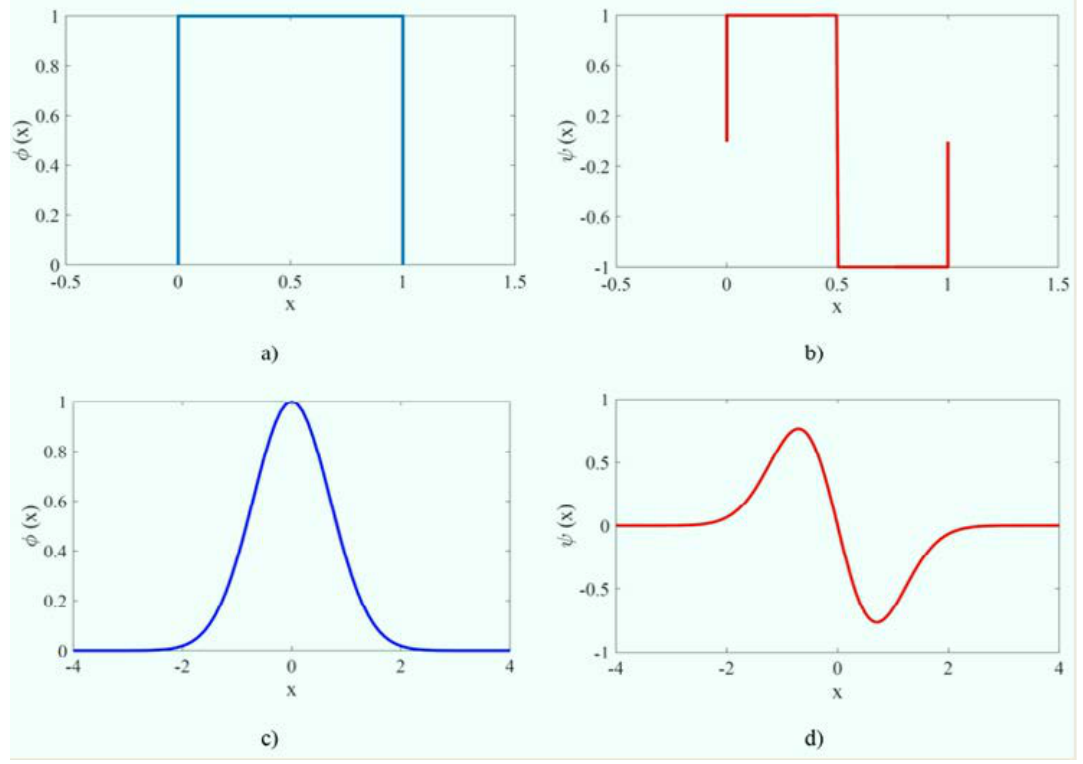
Fig. 2: Two types of wavelet and their corresponding scaling functions: a) Haar scaling function; b) Haar wavelet function; c) Gaussian scaling function; d) Gaussian wavelet function